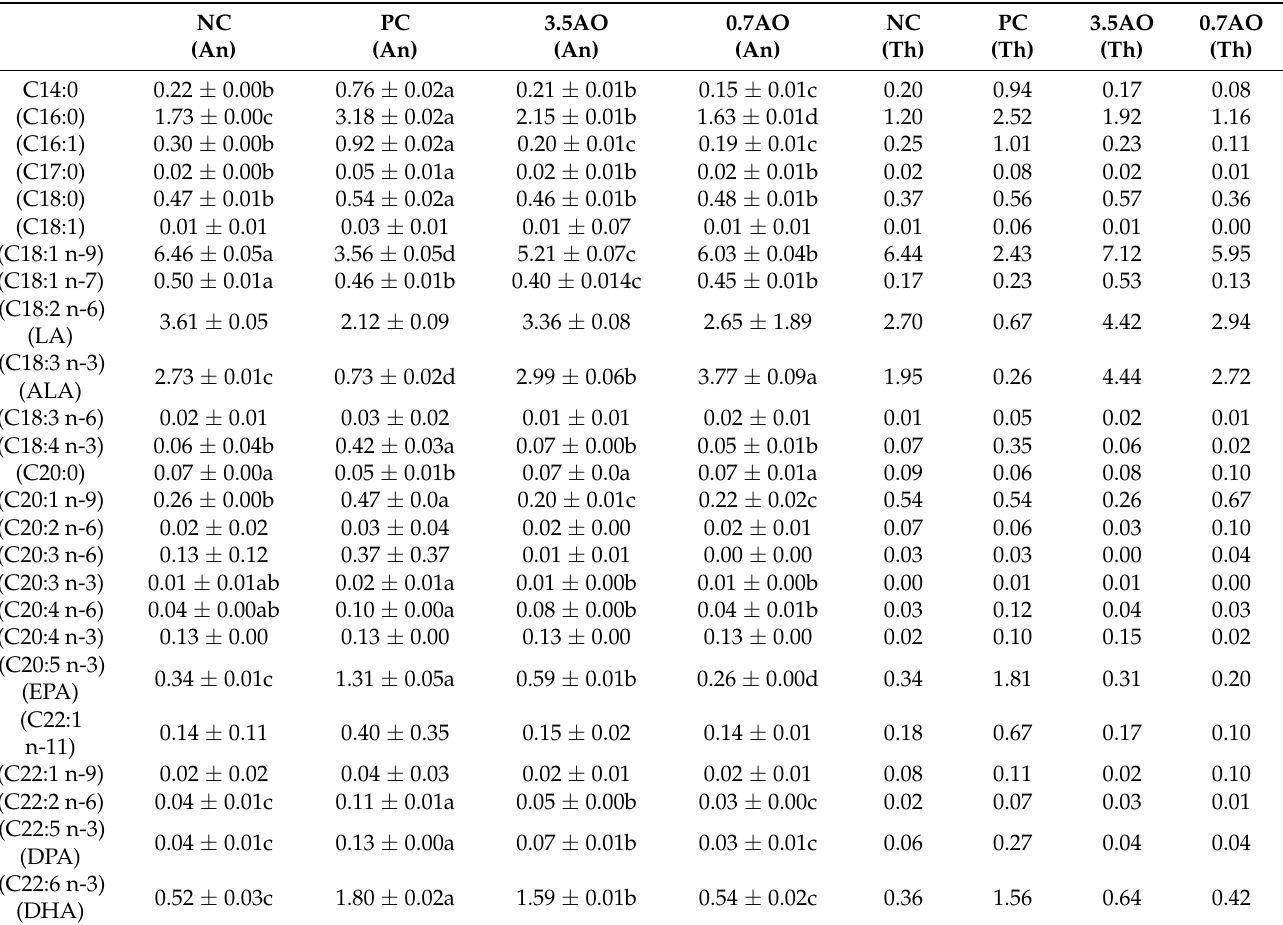
Table A2. Feed fatty acid profile of the experimental diets (% of g/100 g) comparing the analysed amount found in the feed (An) with the theoretically expected amount (Th). NC: Negative control; PC: Positive control; 3.5AO: 3.5% microalgal oil; 0.7AO: 0.7% microalgal